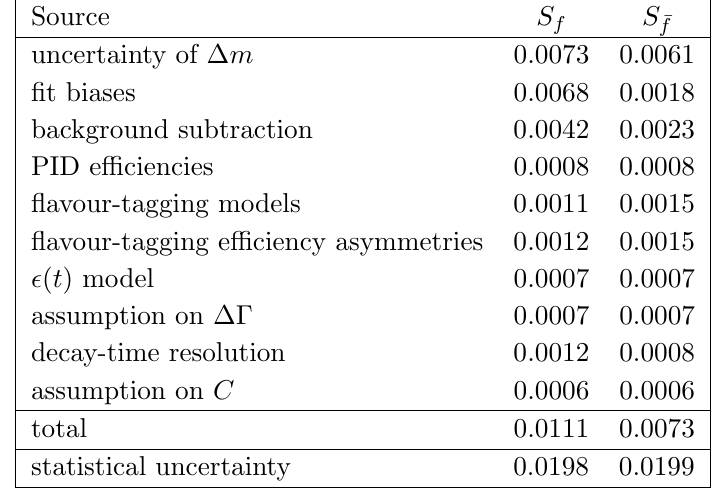
. The total uncertainty is the f